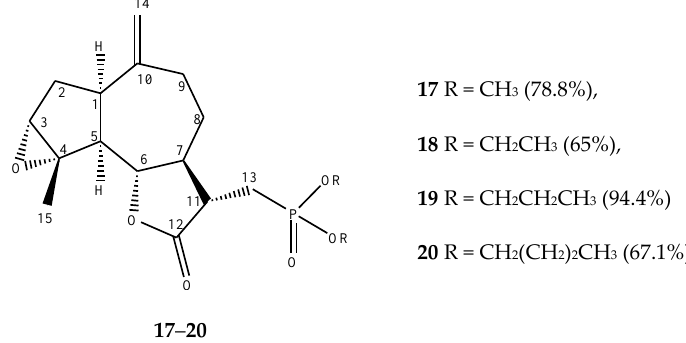
Figure 3. Structures of phosphonate derivatives of estafiatin 17 – 20.